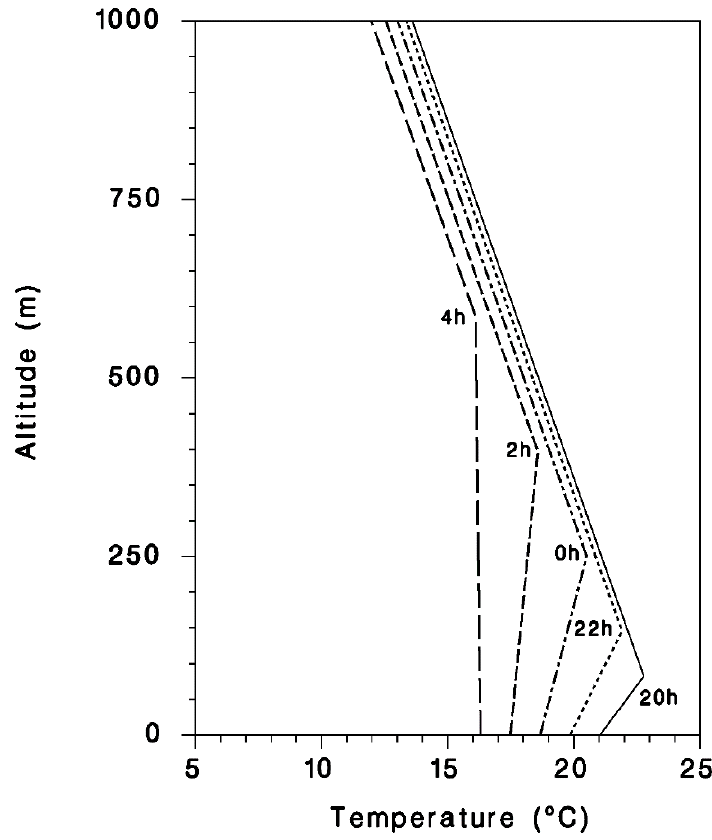
Figure 8. Idealized (archetypal) evening transition and nocturnal boundary layer temperature profile for a clear, calm summer night in northern temperate latitudes. The inversion develops from surface radiative cooling that begins near sunset, increases in depth, and dissipates gradually by early